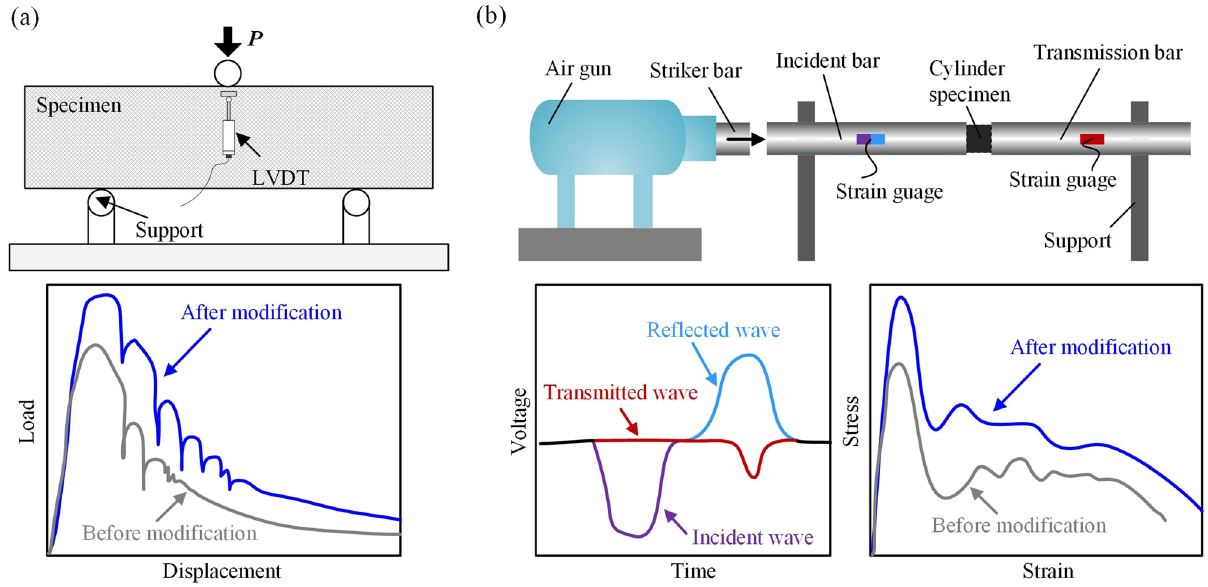
Figure 5: Schematic diagram of static test and dynamic test setup for SFRCC. ( a ) Three - point bending test. ( b ) Split Hopkinson pressure bar ( SHPB ) test. Based on the load – displacement and stress – strain curves, both the static and dynamic performance of SFRCC are enhanced signi fi cantly after interfacial modi fi